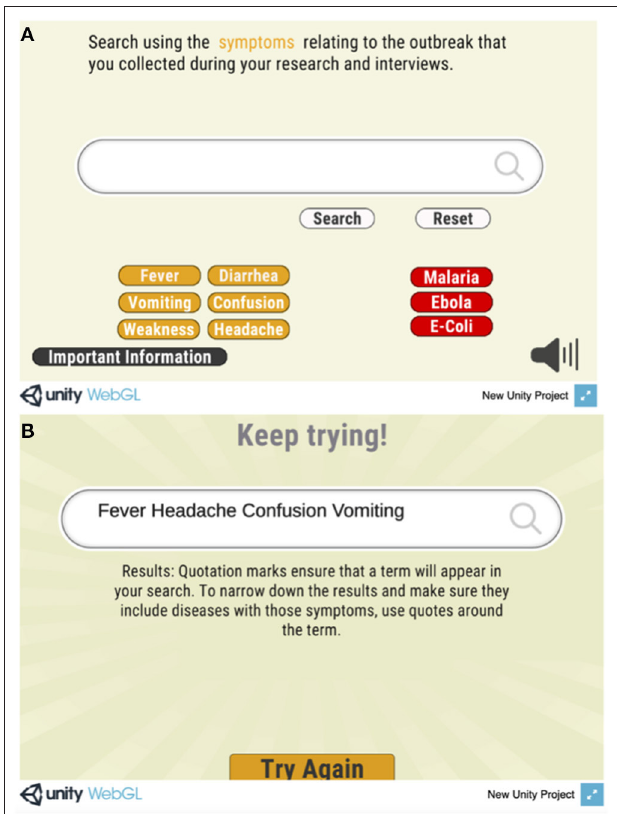
FIGURE 3 | Sequence from the Search Savvy Minigame. In the original prototype, players are prompted to first search for key symptoms identified in the epidemiological investigation (A) . They then receive feedback to search again, this time using quotation marks (applied through the use of a button labeled “Require” in the second step) around critical search terms that must be included in the search (B) . To address feedback, the team has suggested that the first screen of the minigame contain the “Require” button, initially with flashing color and a pop-up hint encouraging players to click “Require” before selecting each